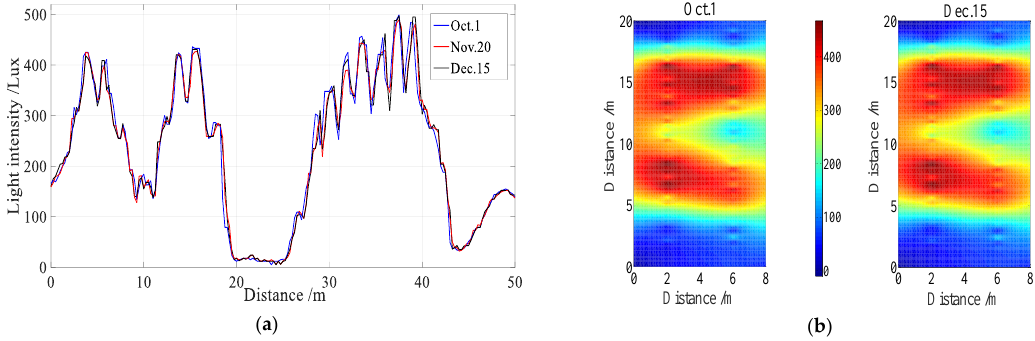
Figure 2. The temporal stability of light intensity. ( a ) Light intensity readings captured at different dates along the same path; ( b ) Light field map captured by smartphone over two months.